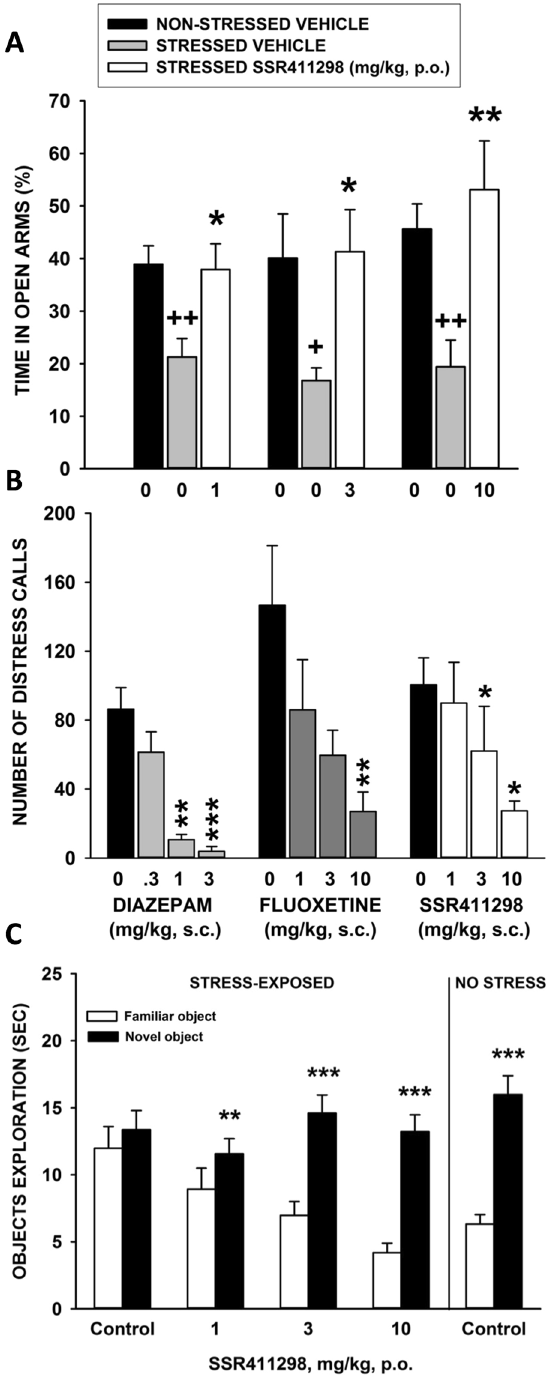
Figure 10. Effects of SSR411298 in several models of anxiety involving prior stress exposure, including ( A ) social defeat induced anxiogenic-like behavior in mice in the elevated plus-maze test. * P < 0.05, ** P < 0.01 (vs stressed vehicle) and + P < 0.05, ++ P < 0.01 (vs non-stressed vehicle). N = 8–13 mice per group; ( B ) ultrasonic distress vocalizations emitted during three minutes by 7-day-old rat pups separated from their mother and littermates. * P < 0.05, ** P < 0.01 and *** P < 0.001. N = 7–10 rat pups/group; ( C ) short-term memory impairment induced by inescapable stress in an object recognition task mice. ** P < 0.01, *** P < 0.001, new vs familiar object. N = 10 mice per group. Data represent mean +